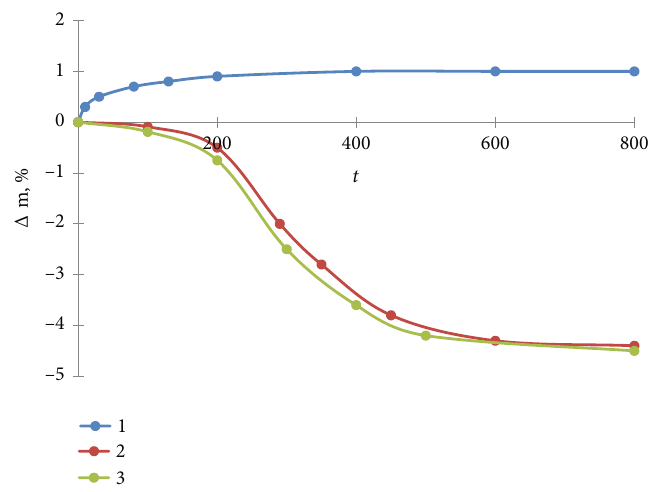
Figure 4: The change in mass ( Δ m) as a function of time (hours) in water for PVC fi lm samples.